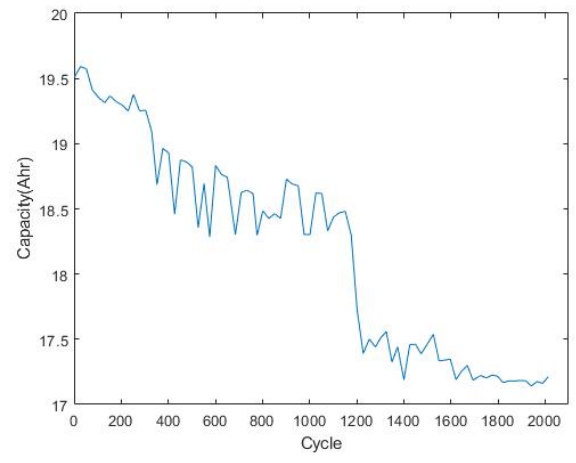
Figure 2 . Battery capacity changes in test cycles. Figure 2. Battery capacity changes in test cycles.